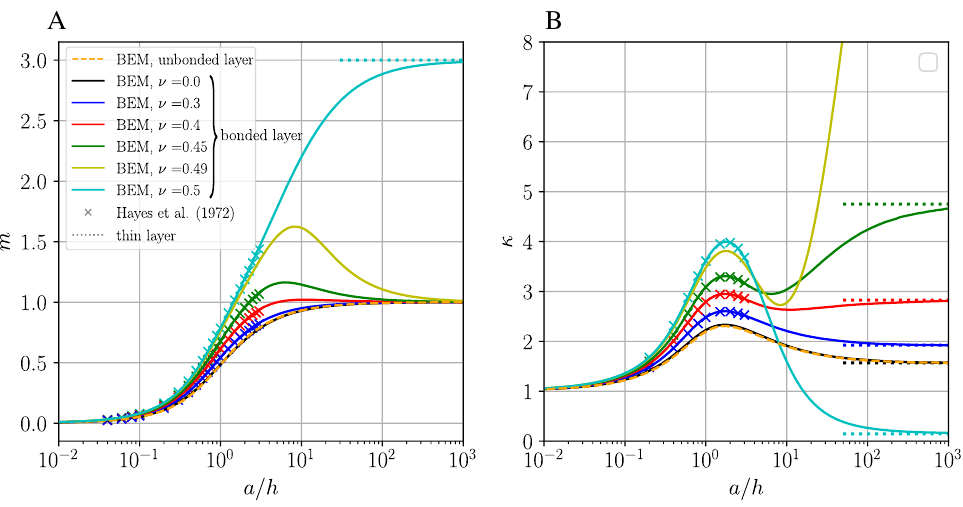
Figure 5. Dimensionless parameters m ( A ) and κ ( B ) of the contact stiffness defined by Equations (33) and (34). Symbols mark numerical data taken from Hayes et al.